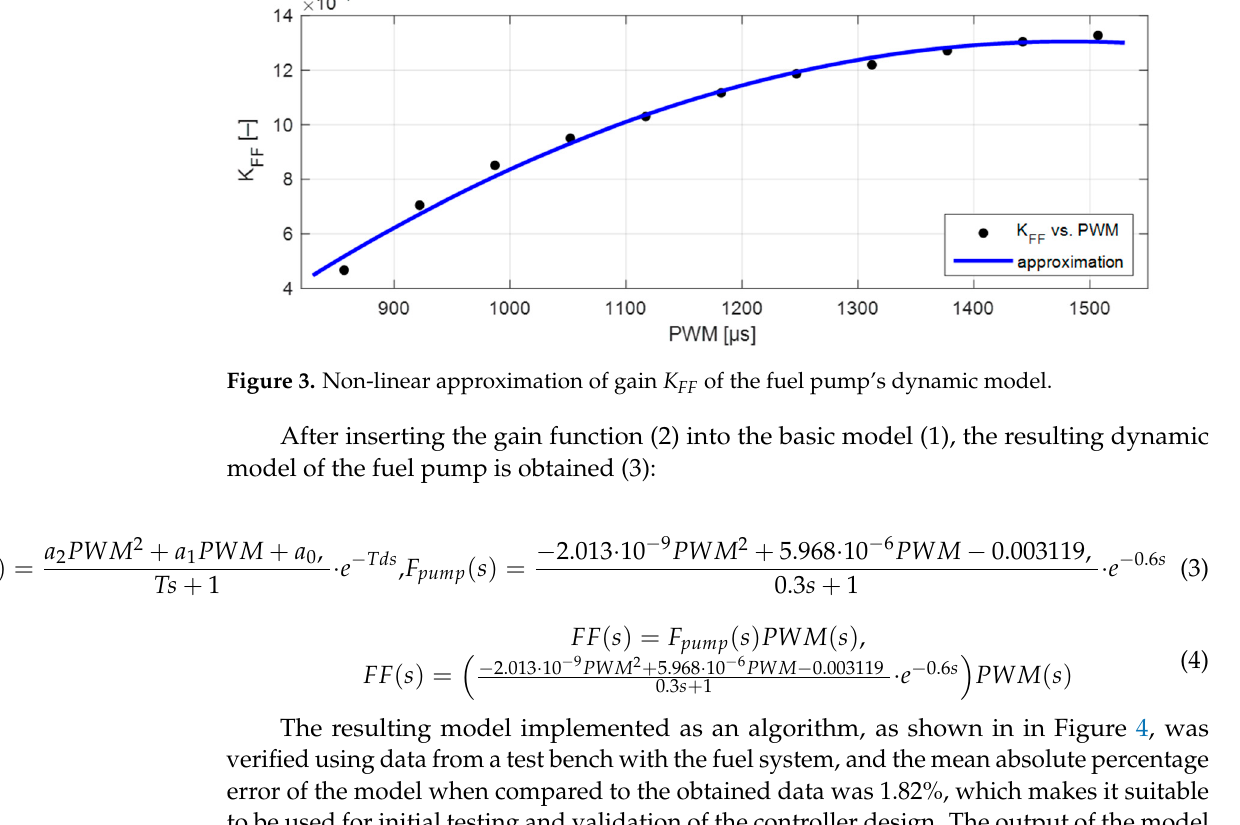
Figure 3. Non ‐ linear approximation of gain K FF of the fuel pump’s dynamic model.